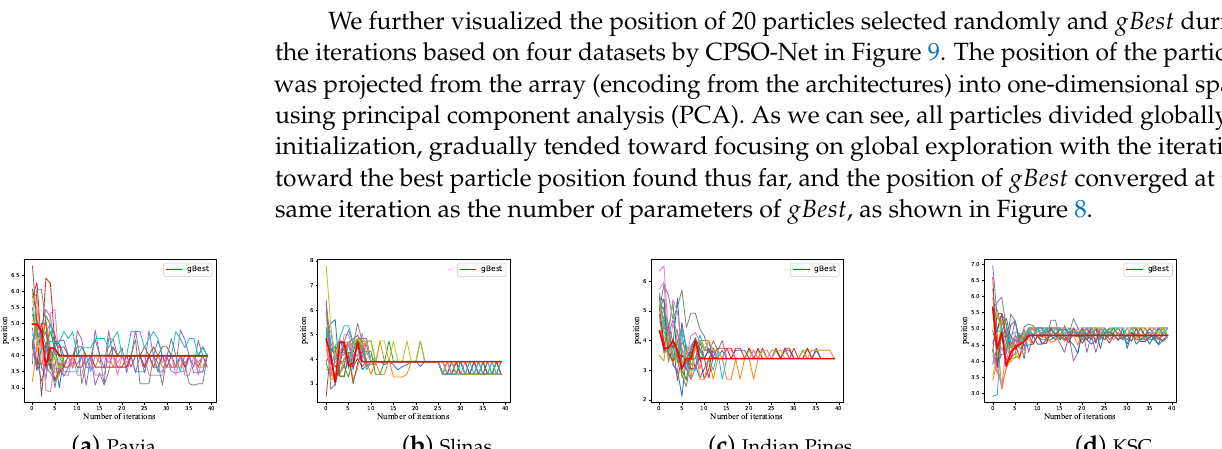
Figure 8. The accuracy and parameters of gBest during the iterations based on four biased datasets by CPSO-Net.